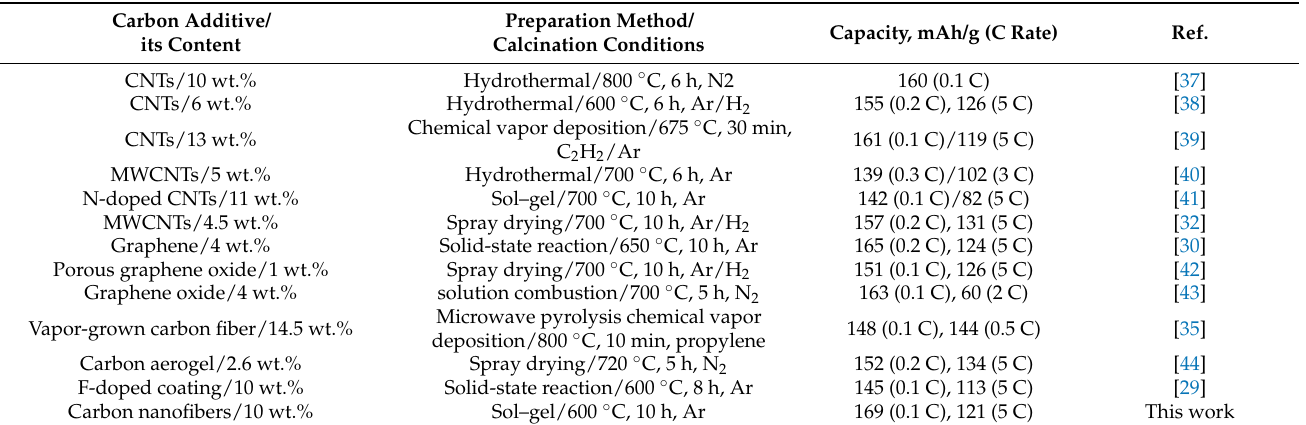
Table 2. The effect of carbon additives on the electrochemical performances of some LFP/C compos-